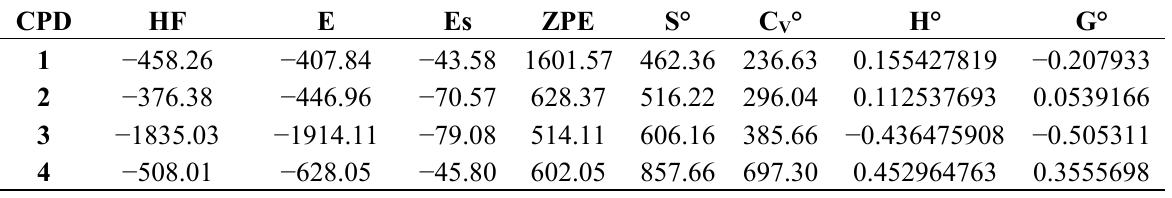
Table 3. The optimized calculatedenergies and thermodynamic parameters atthe semi-empirical PM3 level for 1 – 4 .